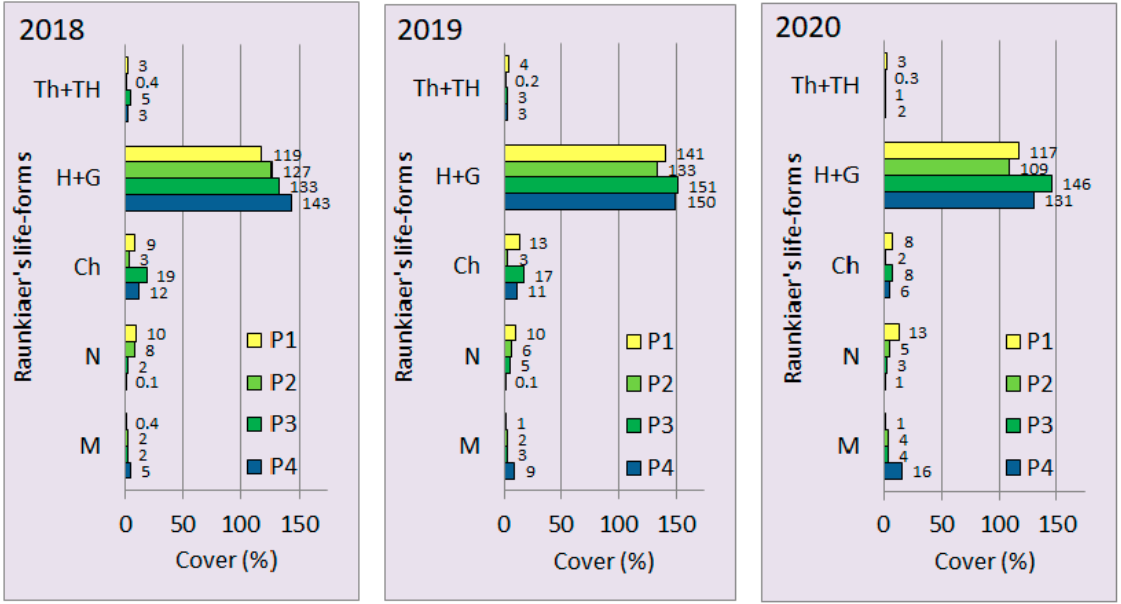
Figure 2. Life-form spectra based on species’ cumulative percentage cover values in the four plots (P1–P4) of “Pócalja” Natura 2000 loess grassland (Central Hungary), in years 2018, 2019 and 2020. Th = therophytes, TH = hemitherophytes, H = hemicryptophytes, G = geophytes, Ch = chamaephytes, N = nanophanerophytes, M = phanerophytes.